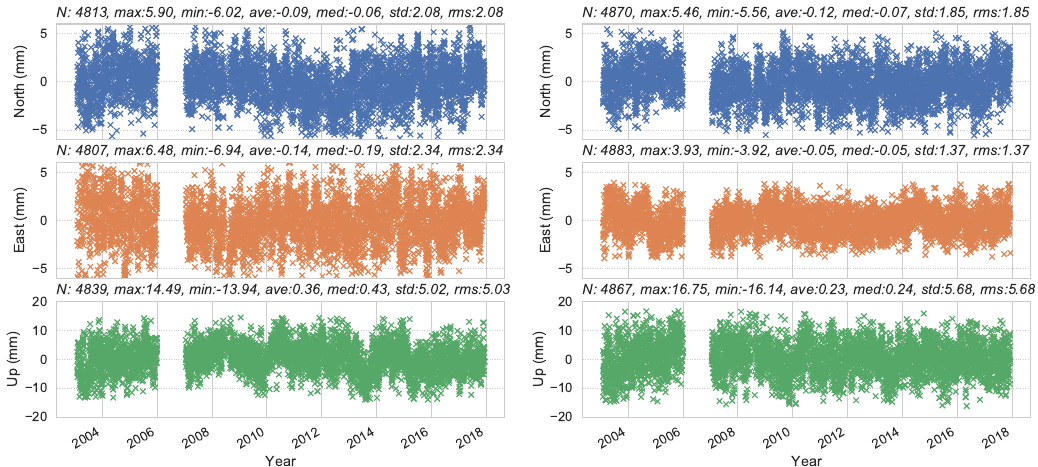
Figure 12. North, East, Up residuals at Aboa after removing the trend and seasonal signals for the RTKLIB ( left ) and GIPSY ( right ) time series [unit: mm].